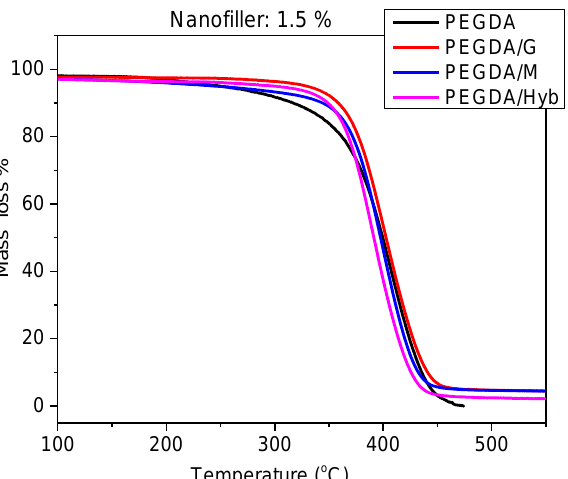
Figure 2. TGA for Neat PEGDA and PEGDA/G, PEGDA/M and PEGDA/Hyb composites, at 1.5% w / w .